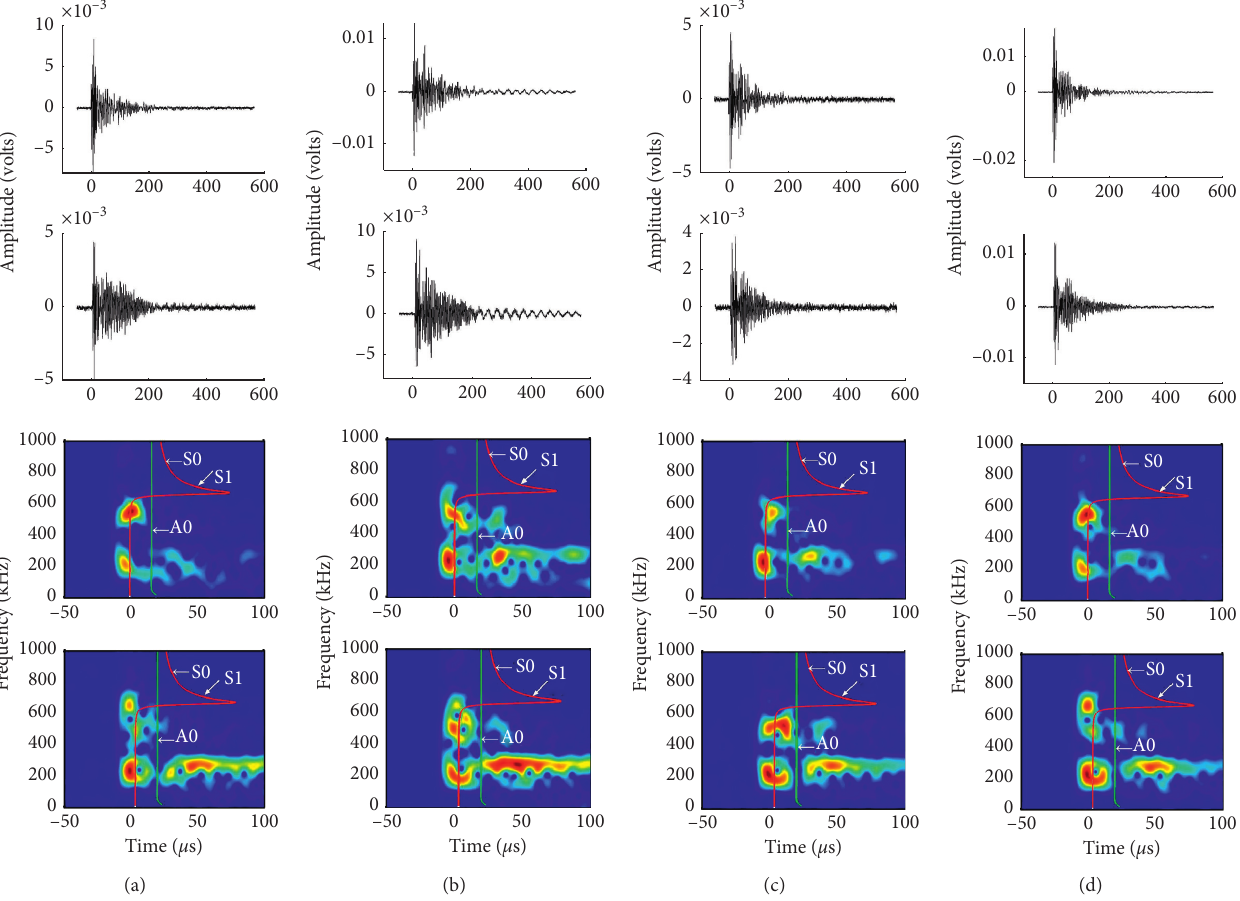
Figure 10: The AE waveform signal and spectrogram in a [0